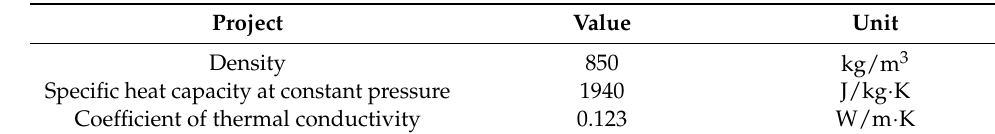
Table 2. Hydraulic oil parameters.